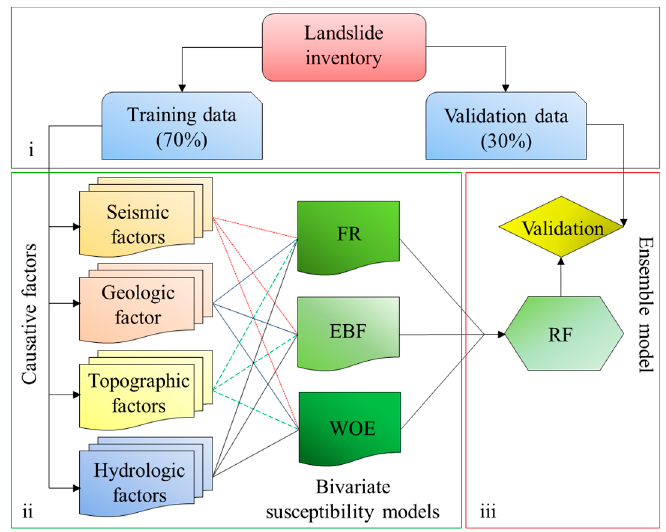
Figure 9. Flow chart of the co-seismic landslide susceptibility modeling.